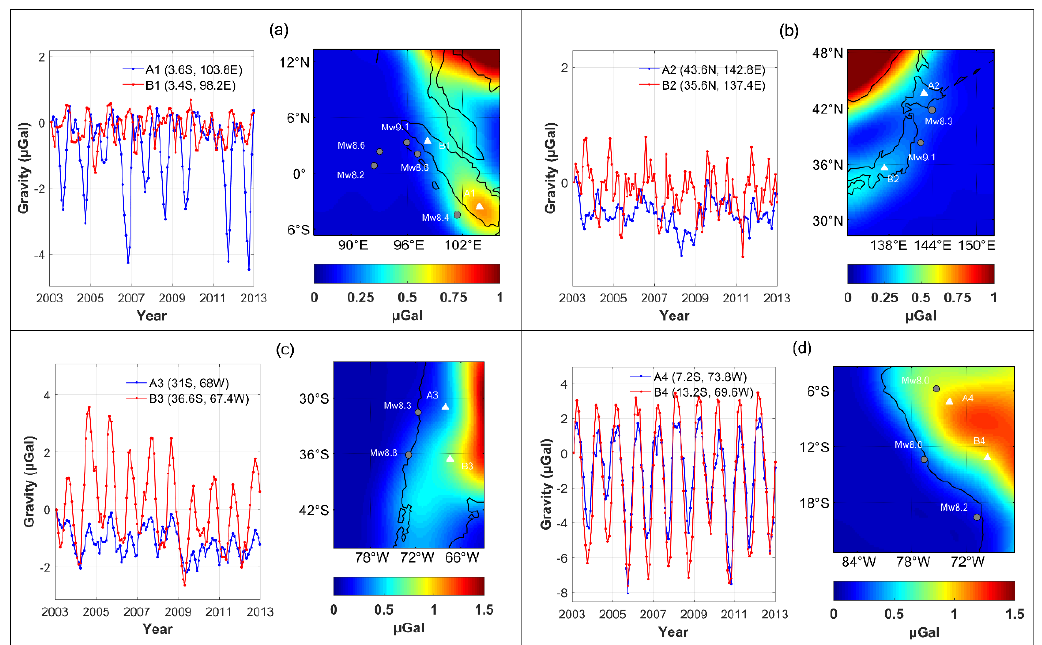
Figure 9. RMS of GLDAS time series from 2003 to 2013 over the earthquake region. The GLDAS time series corresponding to selected points A and B in the left figure, which are marked with white triangles in the right figure. ( a ) Sumatra region; ( b ) Japan region; ( c ) Chile region; ( d ) Peru region. Note the colorbar range differs among the subfigures.